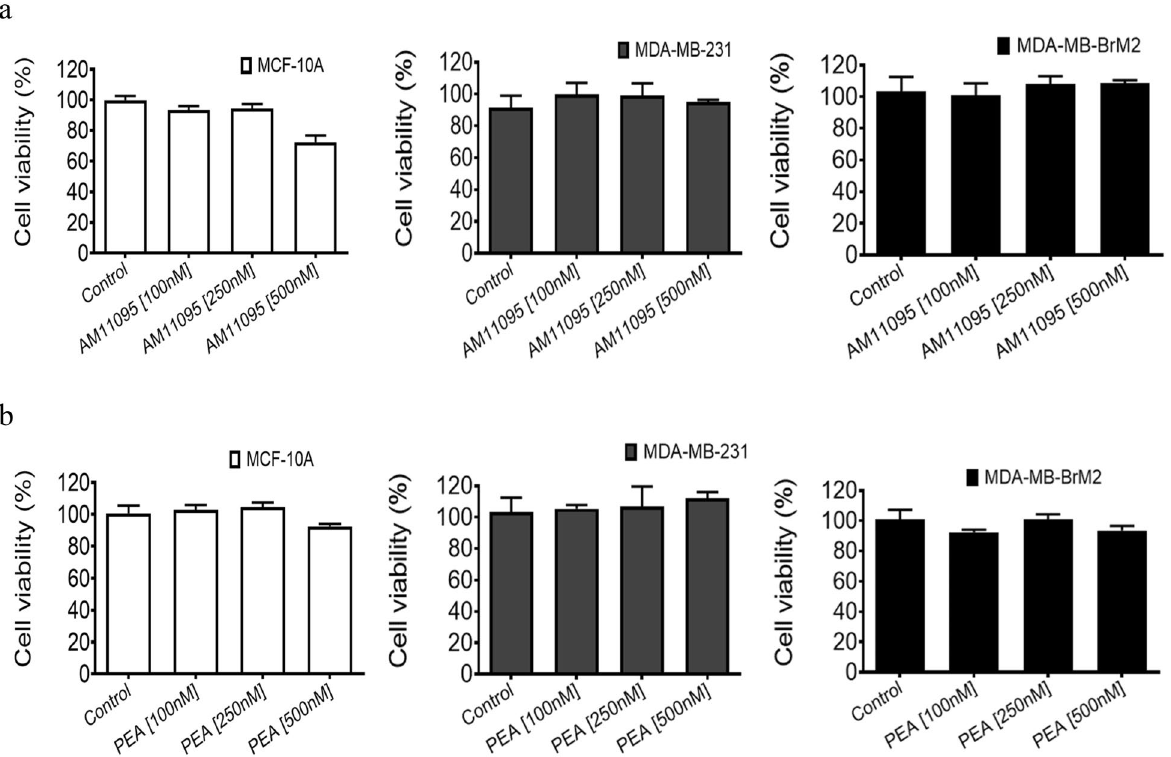
Figure 2. Effect of PEA or AM11095 on cell viability as well as the effect of AM11095 on PEA level in breast cancer cells. ( a ), ( b ) Effects of AM11095 (panel a ) or PEA (panel b ) on cell viability on non-tumorigenic and breast cancer cells. MCF10A, MCF-7, MDA-MB-231, and MDA-MB-BrM2, 5 × 10 4 cells/well were incubated for 72 h with AM11095 or PEA at different the concentrations noted in the Figure. Cell viability was assessed using the MTT assay. The percent viability is presented as the means ± S. D (n =